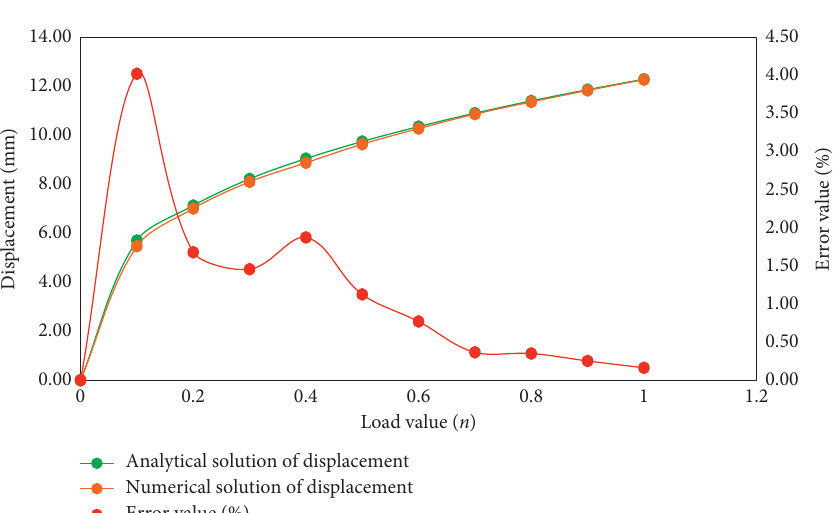
Figure 6: Curve comparison of numerical solution and analytical solution of unit point displacement of badminton racket.